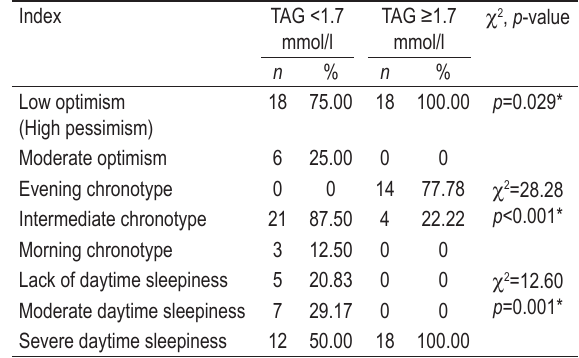
TABLE 4. Frequency of hypertriacylglycerolemia registration according to the criteria of metabolic syndrome in patients with arterial hypertension depending on dispositional optimism, chronotype, and